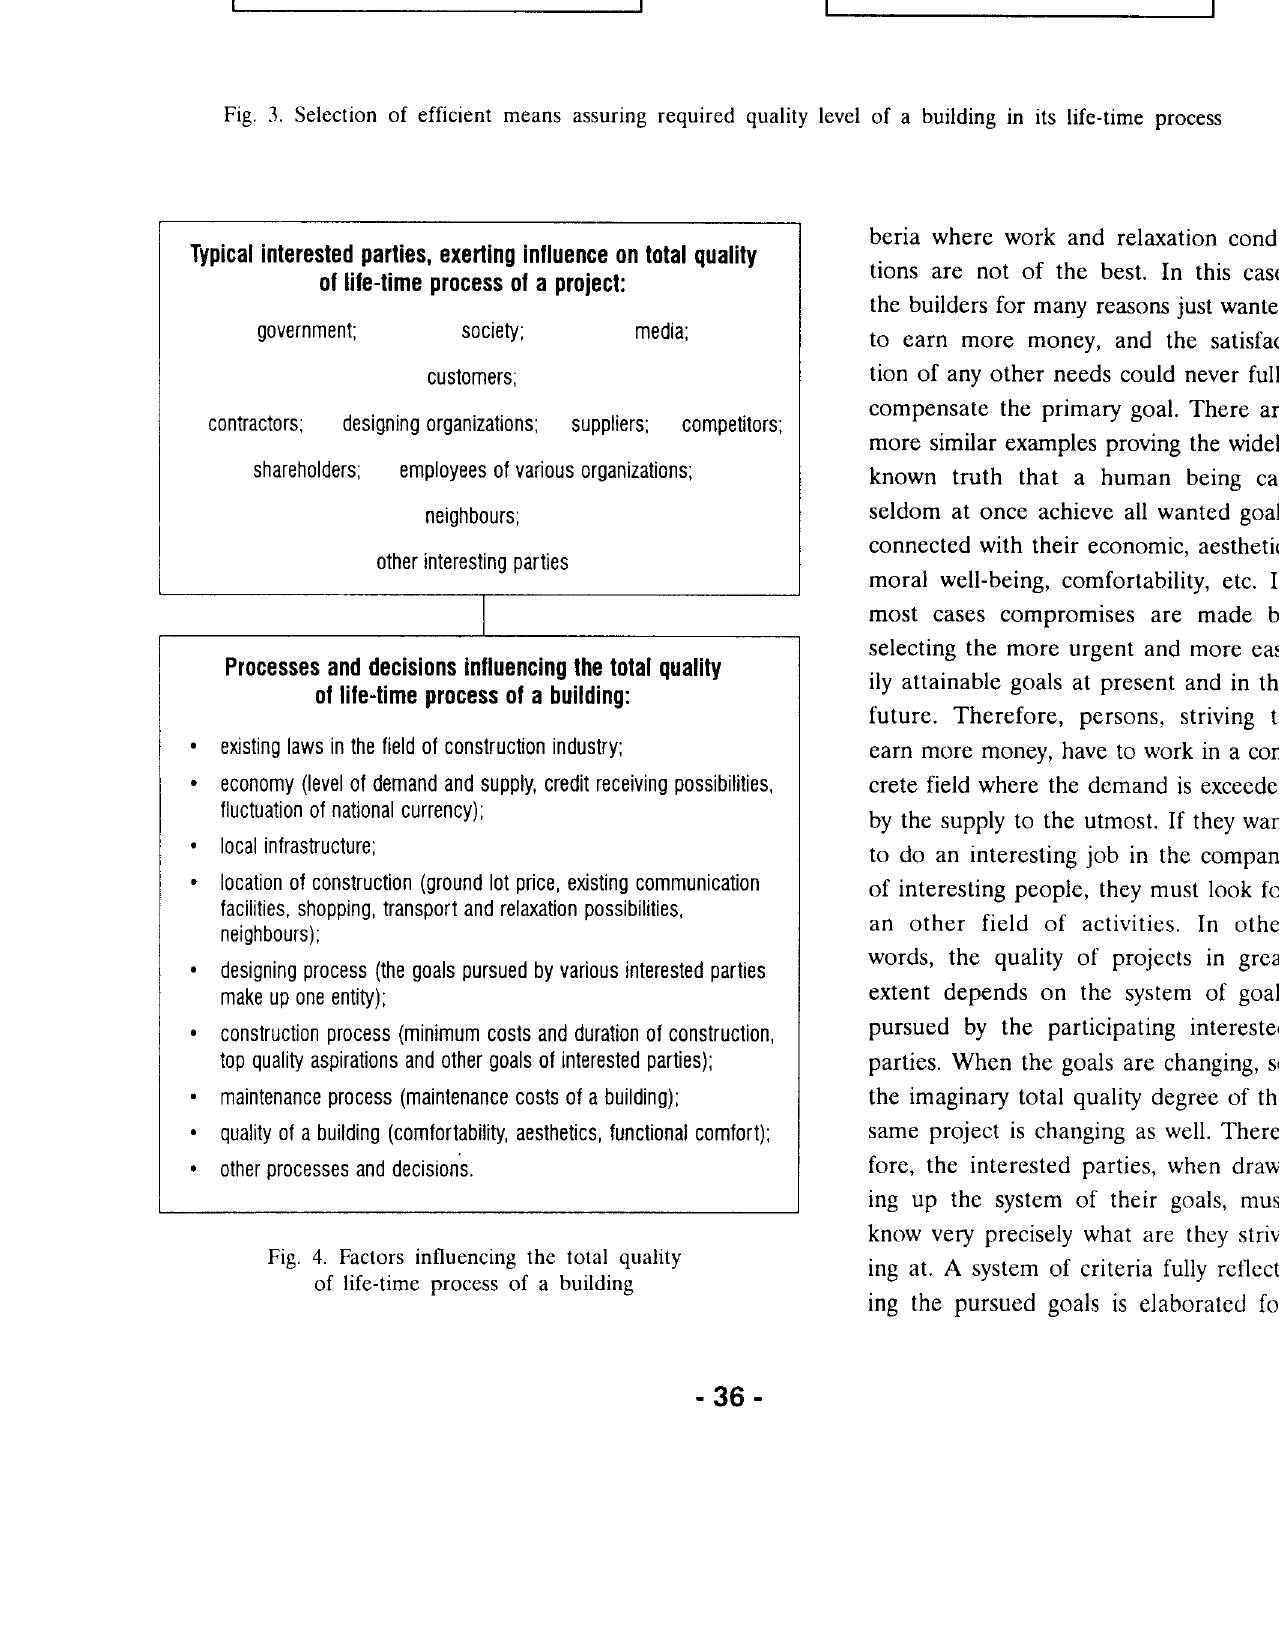
Fig. 3. Selection of efficient means assuring required quality level of a building in its life-time process